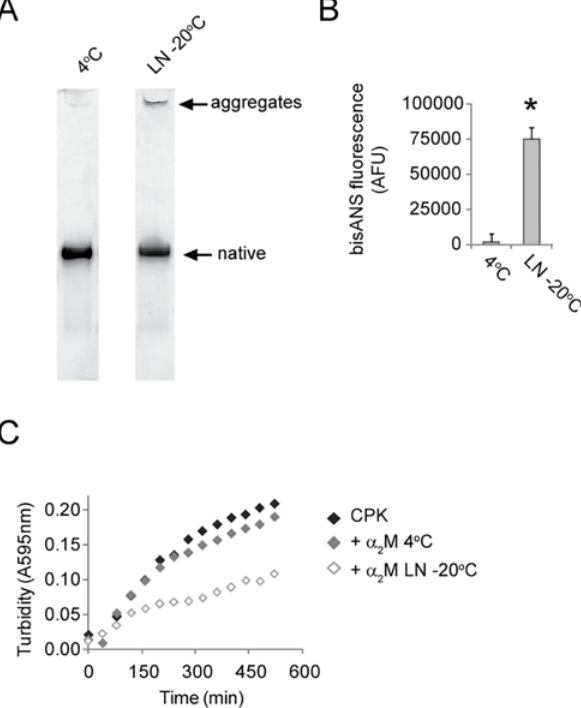
Fig 5. The effect of storage at -20°C on α 2 M chaperone activity. (A) Images of native PAGE (3 – 8% Tris- acetate) analyses of α 2 M stored in 20 mM phosphate buffer, pH 7.4 (4°C or -20°C, 1 month). The latter sample was rapidly frozen in LN prior to storage at -20°C. (B) Corresponding bisANS fluorescence measurements for the α 2 M samples described in (A). The results shown are the values of the mean bisANS fluorescence (n = 3 ± SD) in AFU. * Denotes significantly increased bisANS fluorescence as a result of storage at -20°C (Student ’ s t-test p < 0.01) (C) Turbidity measurements of CPK aggregation in the presence or absence of α 2 M which had been stored at 4°C or -20°C as described in (A). The data are from individual measurements and are representative of several different